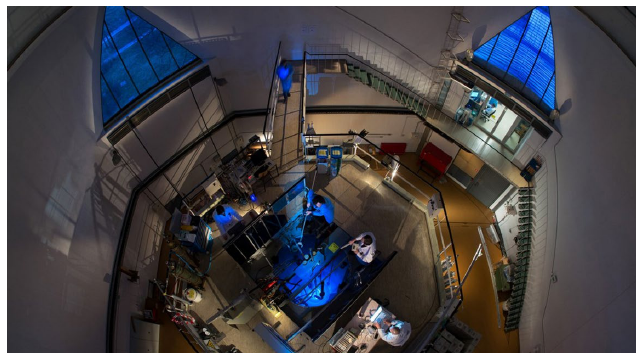
Fig. 1 . JSI TRIGA reactor, JSI, Ljubljana.